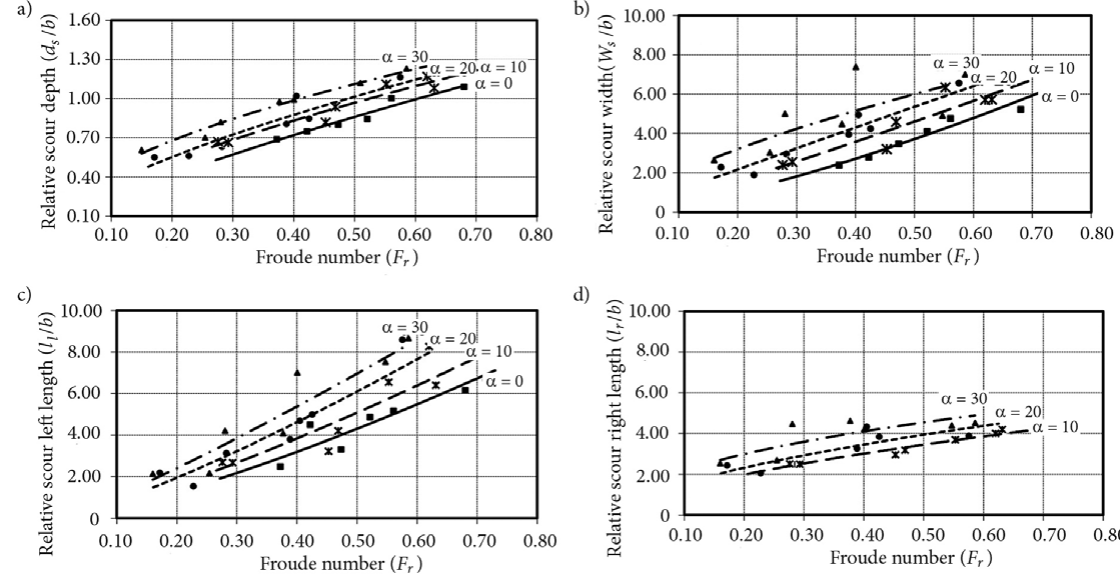
Figure 7. Froude number against relative scour depth, width, left side length and right side length with the varying skew